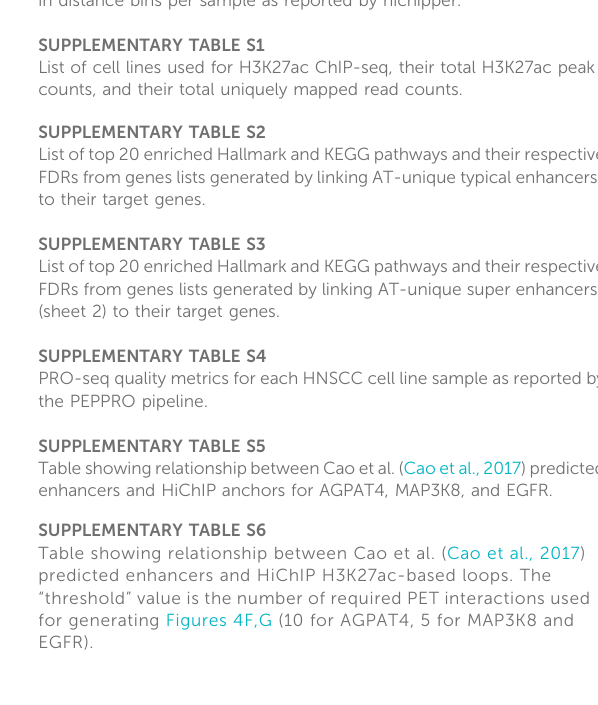
SUPPLEMENTARY TABLE S2 List of top 20 enriched Hallmark and KEGG pathways and their respective